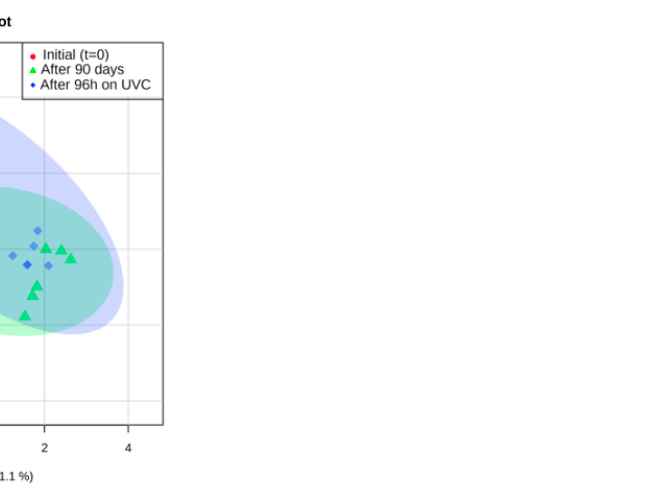
using partial least squares analysis (PLS-DA) were applied using the MetaboAnalyst 5.0